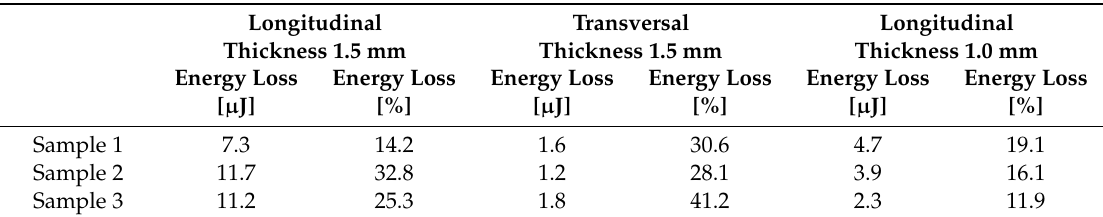
Table 3. Hysteresis losses for di ff erent samples of wet natural reed.